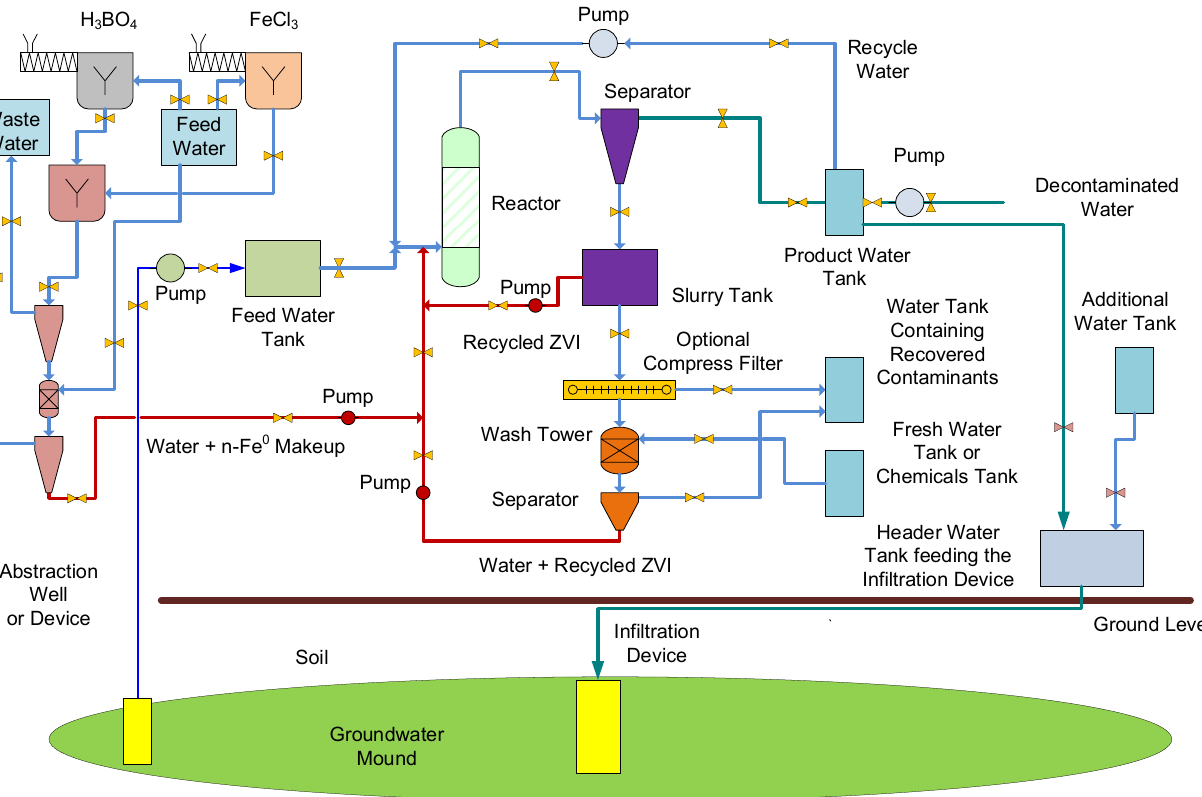
Figure A7. Process flow diagram illustrating how n-Fe 0 could be used to remediate a soil using a constructed groundwater mound.